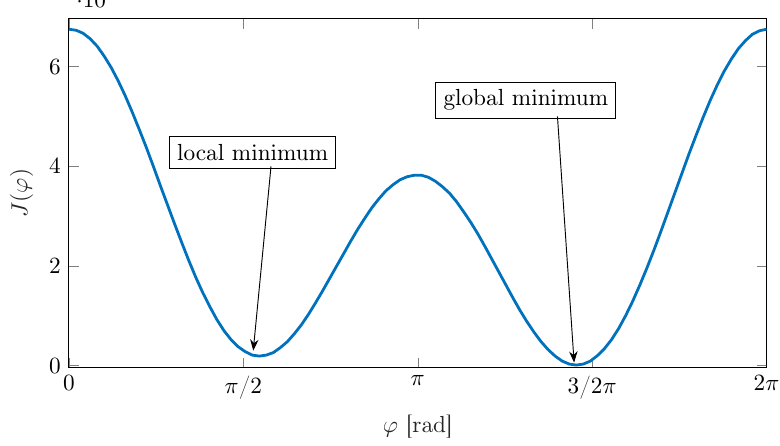
Figure 2. Example of cost function (10) for different voltage phase angle